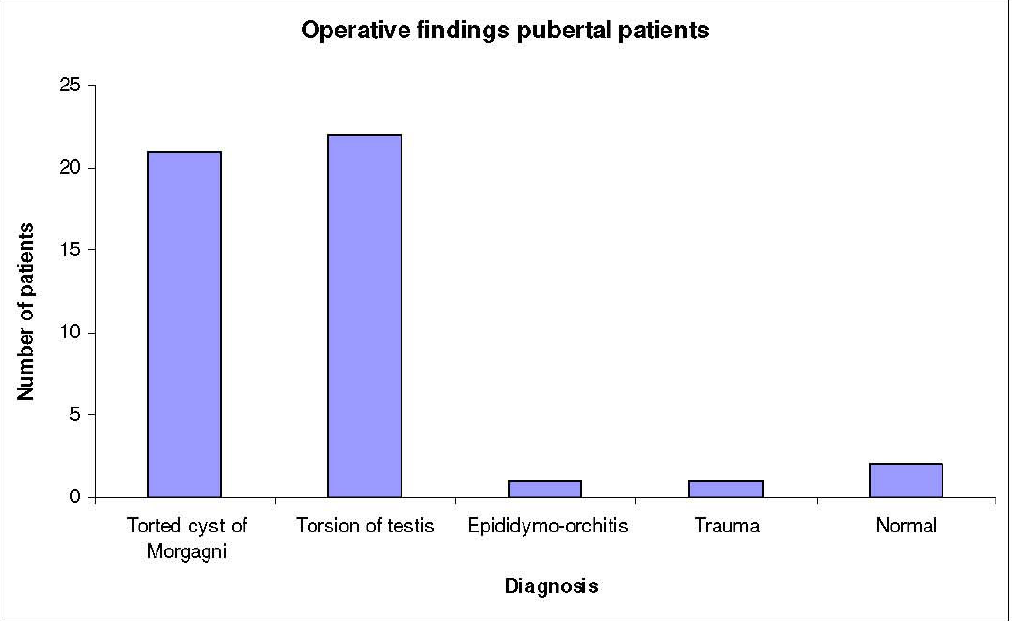
FIGURE 2. Operative findings in scrotal exploration in pubertal patients (n =